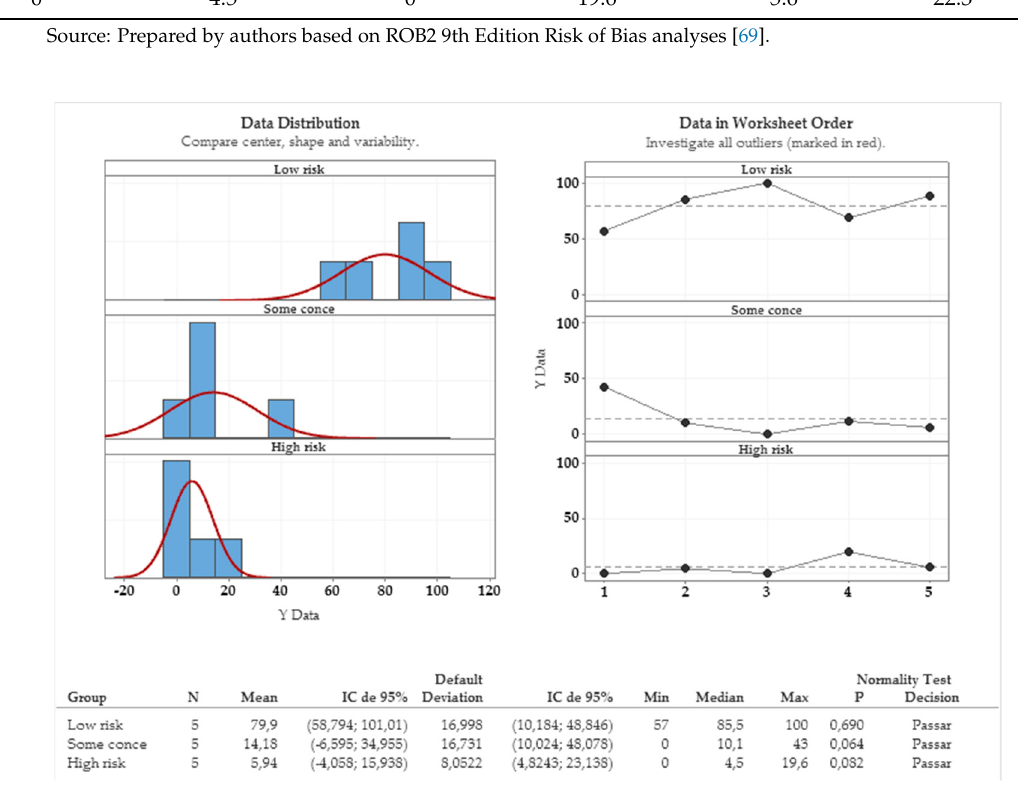
Figure 2. Analysis of the risk of bias results. Source: Prepared by the authors using Minitab® 19 software [39,70]. (Some information contained in this publication is printed with permission of Minitab,